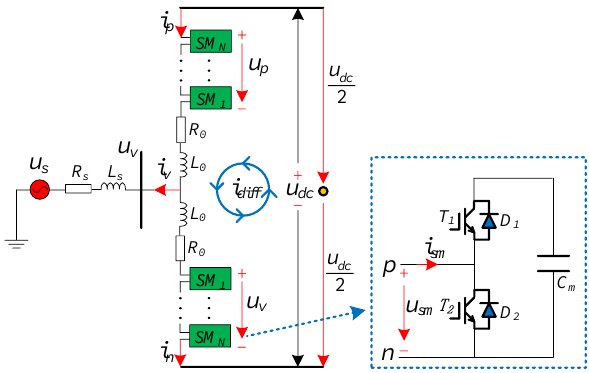
Figure 2. Structural diagram of MMC on inverter side and its submodule (SM).